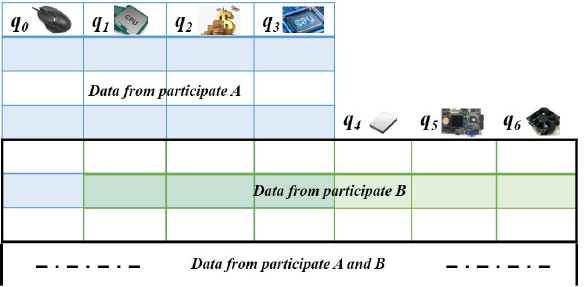
Figure 4. Vertical federated learning of multi − dimensional data.